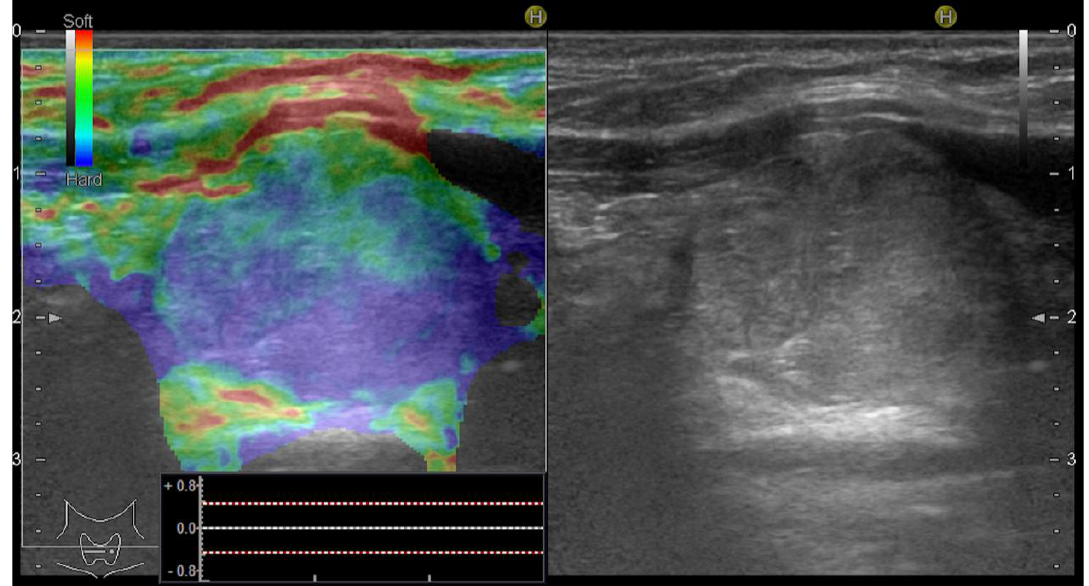
Figure 6. Risk upgrade from intermediate risk in B-mode to high risk in B-mode + SE due to increased stiffness (Asteria 3). Pathology report confirmed PTC.